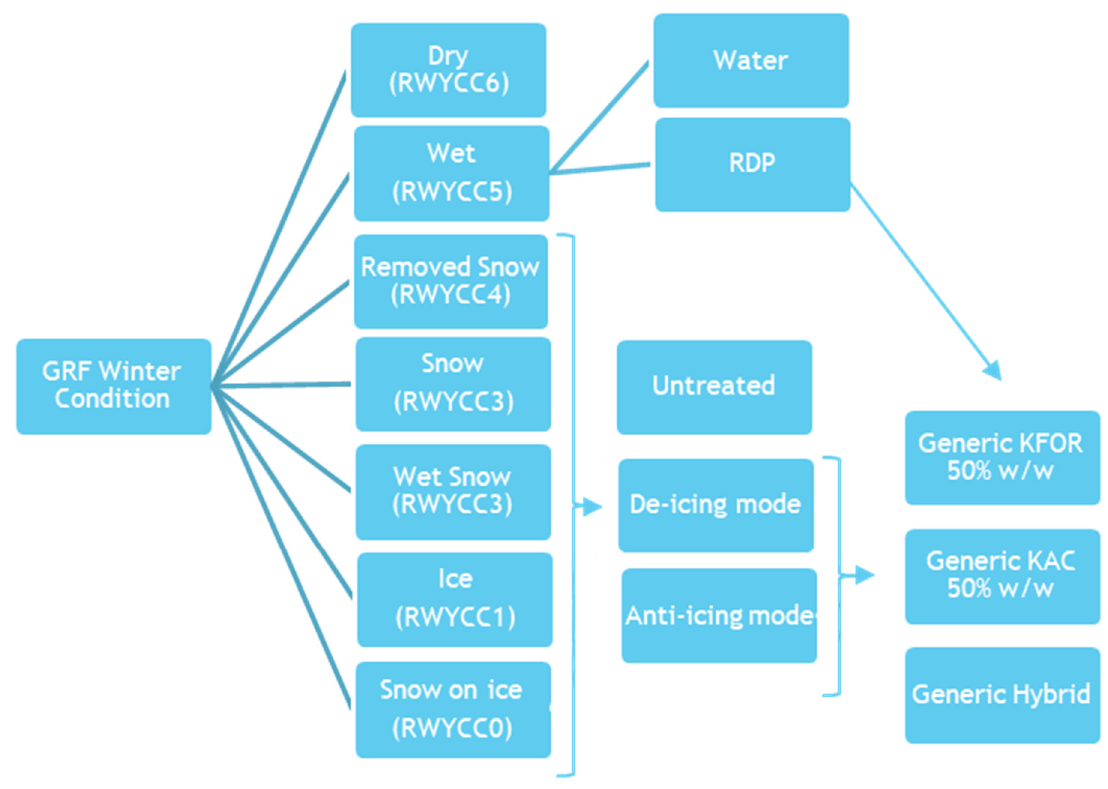
Figure 2. Test plan of the seven GRF icing conditions [22] selected for this study.